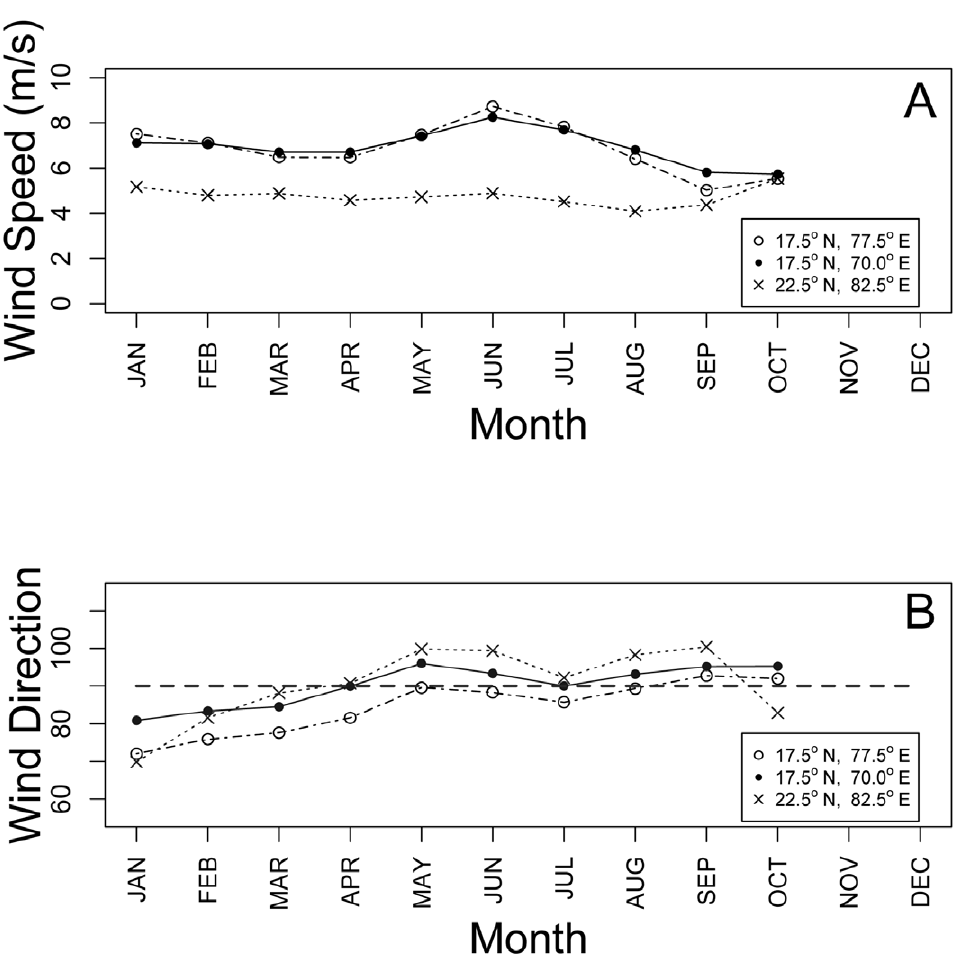
Figure 3. Seasonal wind patterns in the study area. Time series plot of mean wind magnitude (a) and mean wind direction (b) at three locations within the study area. Dashed line in (b) is included as a 90 u (east) reference.